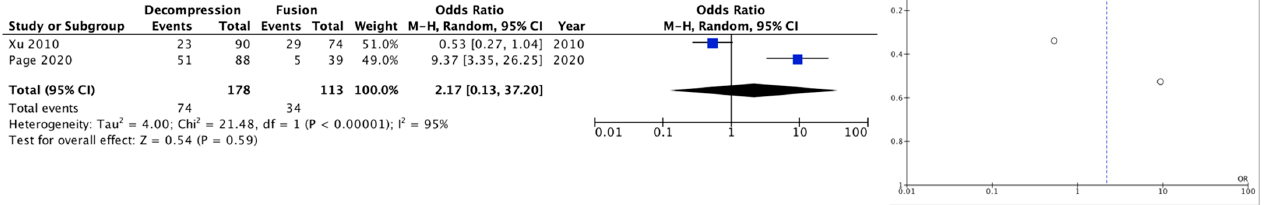
Figure A5. Sensory de fi cit.